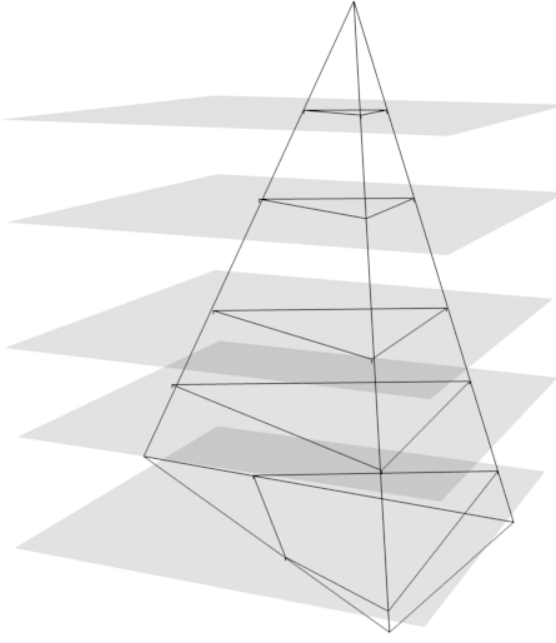
Figure 3. Transverse intersection of a planar foliation with a 3-simplex in general